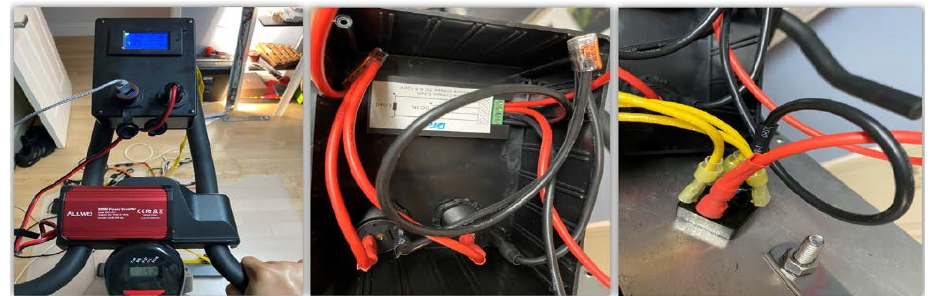
Figure 10. The electrical components on the prototype.